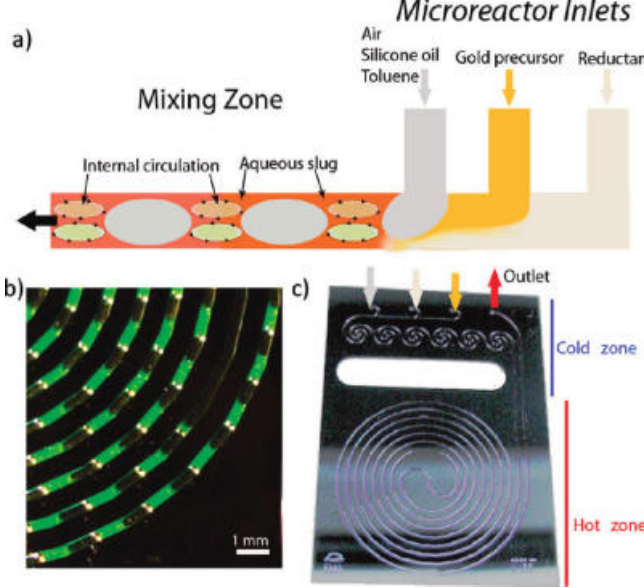
Figure 23. ( a ) Schematic of the segmented flow generation in a microfluidic reactor; ( b ) Detail of segmented slugs generated at a residence time of 10 s. The aqueous slug (continuous phase) contains fluorescein (green color); the disperse phase is toluene; ( c ) Spiral silicon/Pyrex microfluidic reactor designed for gold nanocrystal synthesis (400 μ m channel width and depth, 100 μ L reaction zone volume)